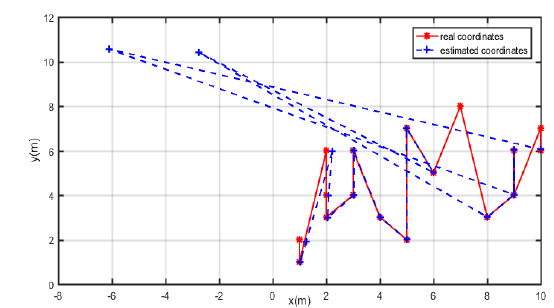
Fig.1 .localization using trilateration technique [14].